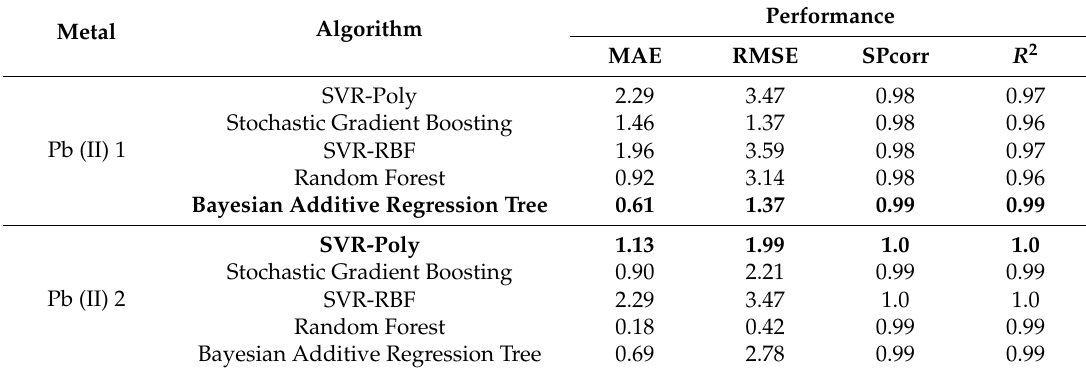
Table 9. The performances of five (5) MLA models on independent test data (20%) of Pb(II) datasets. Metal Algorithm